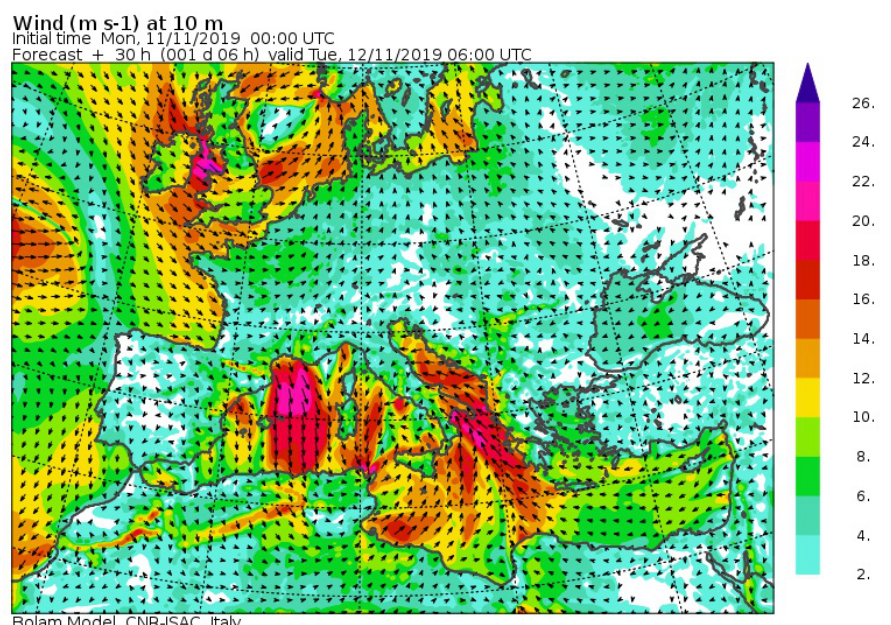
Figure 3. Wind speed at a 10 m height on 12 November 2019 at 6.00 UTC; note the quite long fetch down to the Libyan coast; image downloaded from [32].